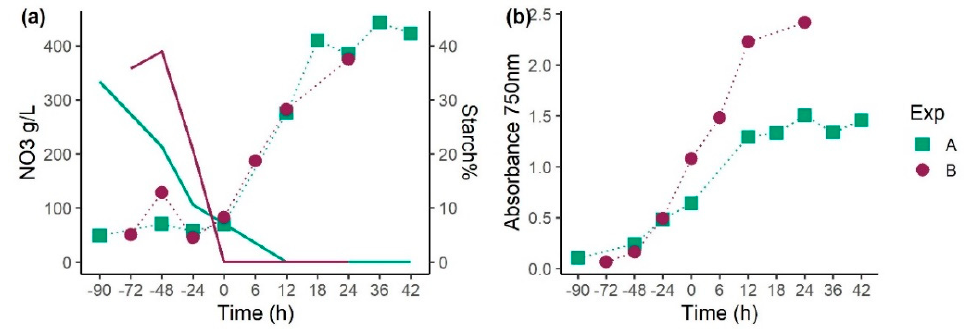
Figure 6. Time sequence of two experiments growing C. vulgaris in limiting medium containing 20% nitrogen in experiment 3. Experiment A was harvested after 24 h from starvation (x = 24), experiment B was harvested 36–48 h after starvation. ( a ) Nitrate content in the medium measured with ion chromatography (solid line) and starch accumulation in the cells (dotted line) ( b ) Absorbance at 750 nm.